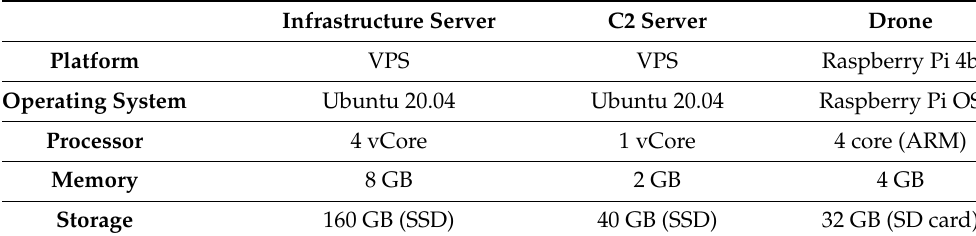
Table 4. Inventory of materials.